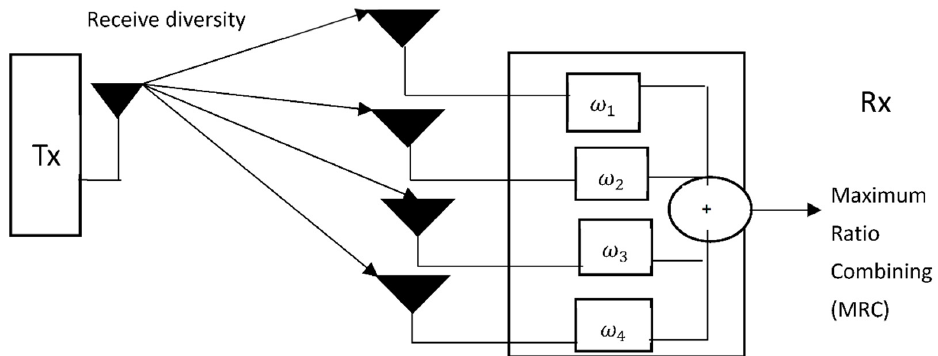
Figure 14. Receive diversity in